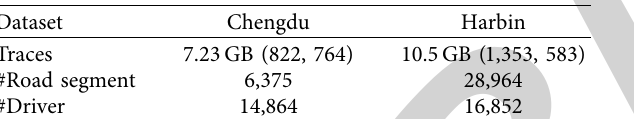
Table 3: Real dataset